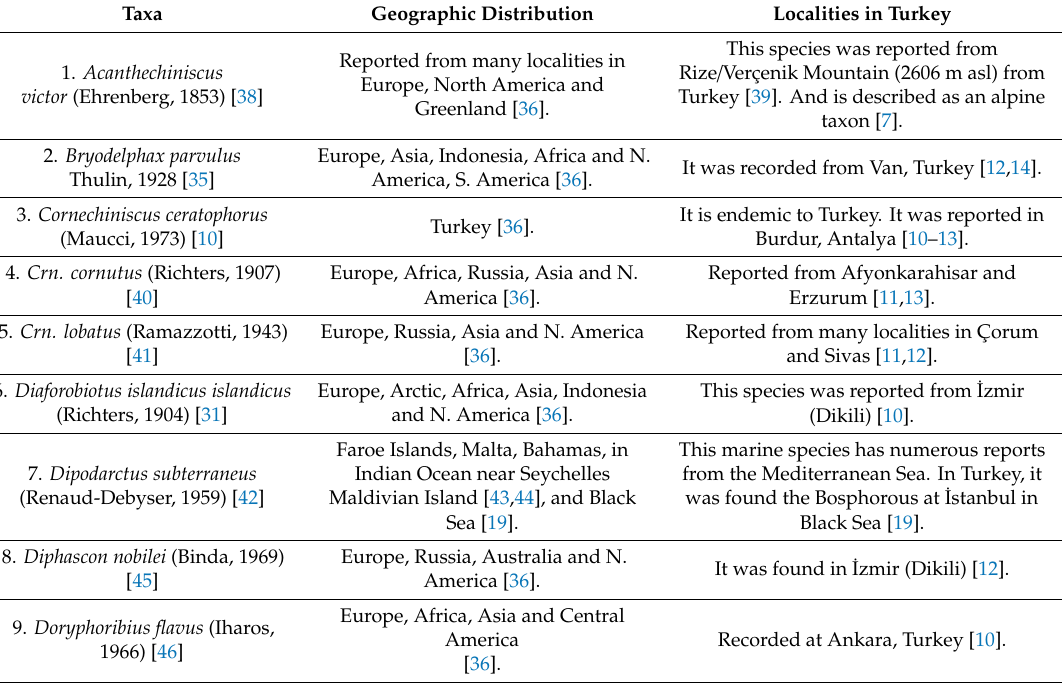
Table 2. The final list of all reported tardigrade species (marine and terrestrial) from